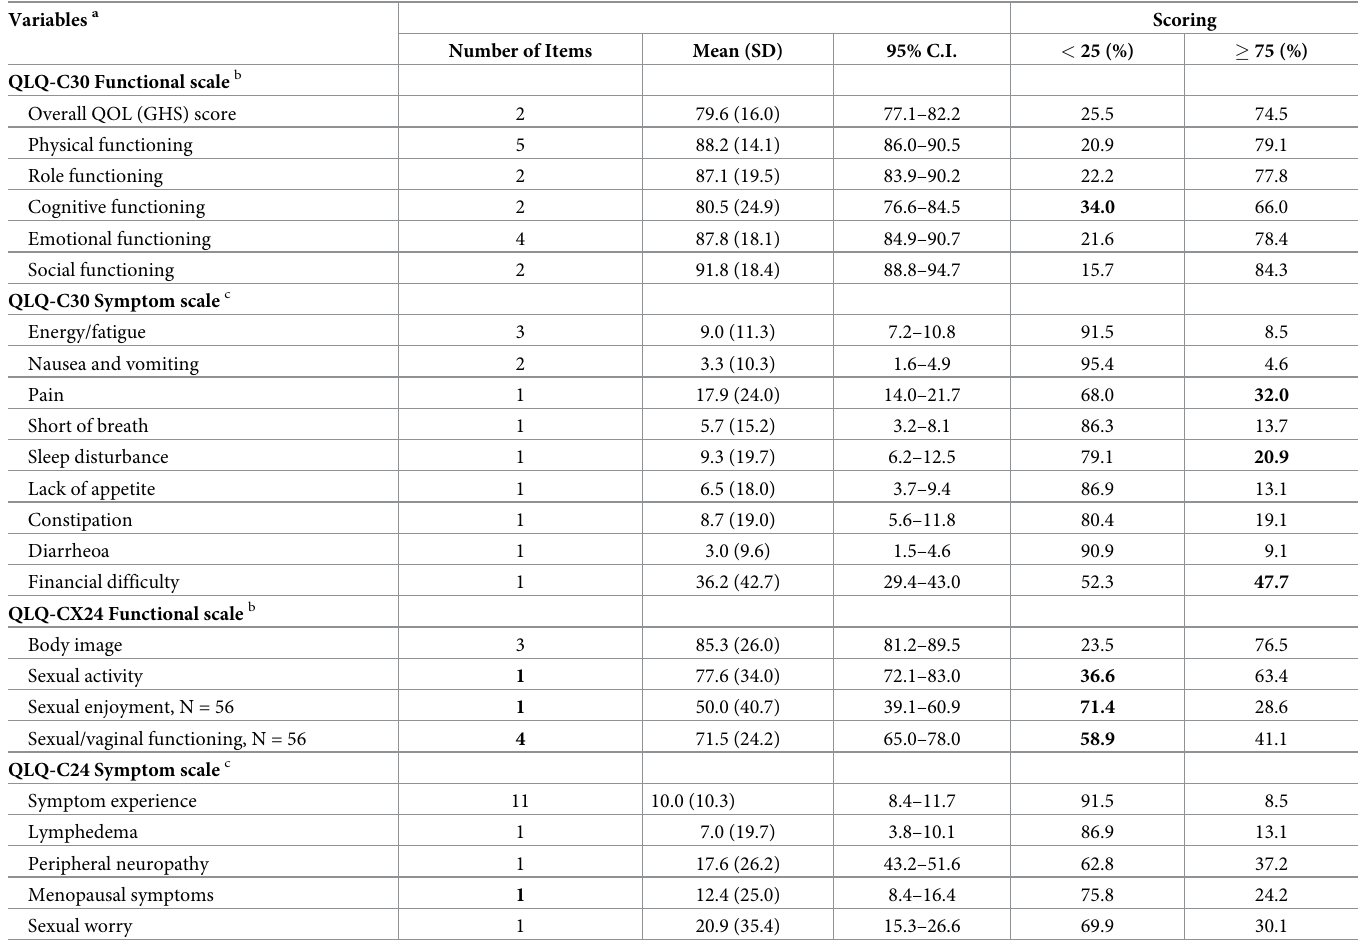
Table 3. EORTC QLQ-C30 & QLQ-CX24 of among cervical cancer survivors after treatment. Variables